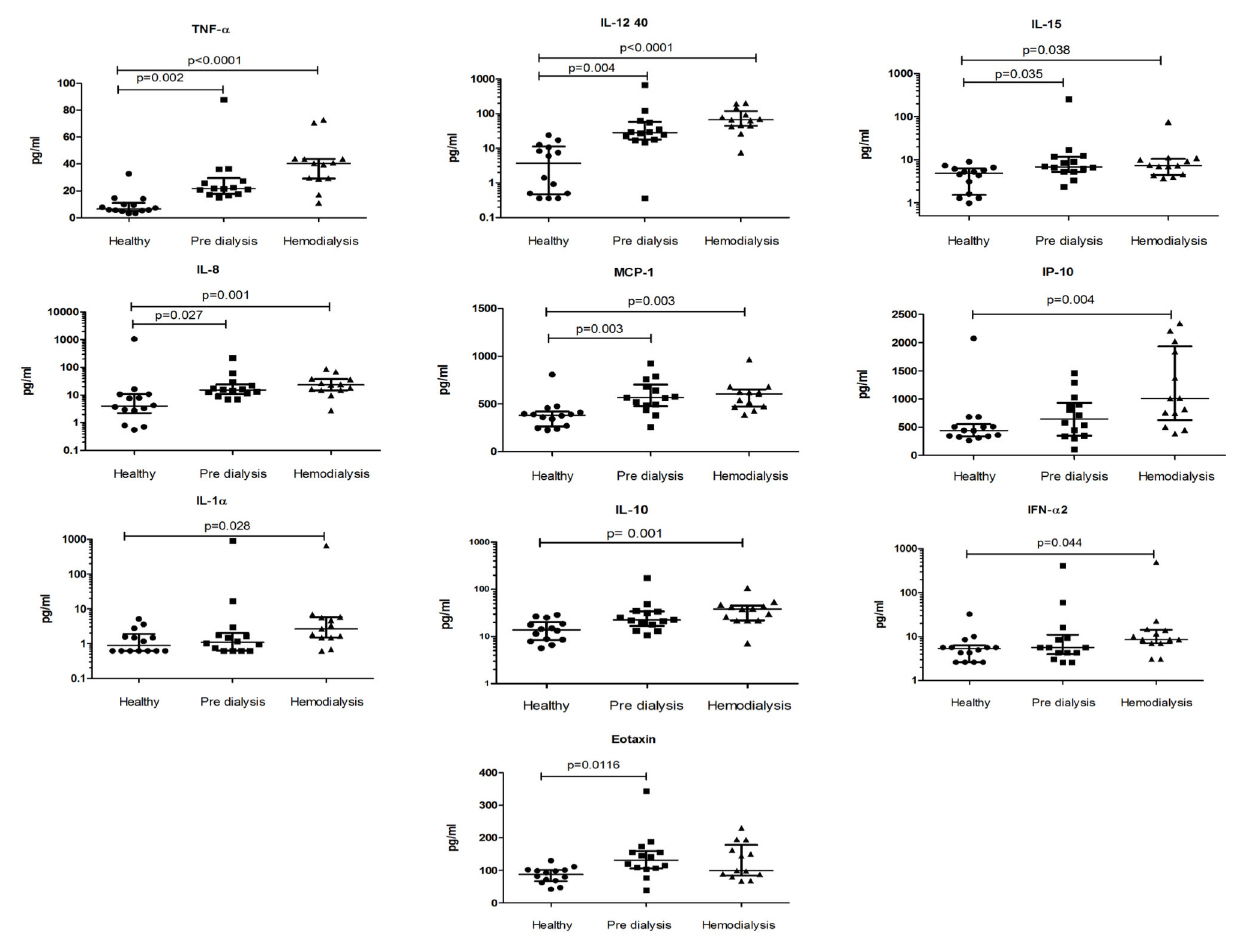
Figure 2. Scatter plots showing cytokines with significantly different plasma concentrations (pg/ml). The concentration of soluble immune modulators in the plasma of healthy controls, pre-dialysis patients and hemodialysis patients were analyzed and compared. Whiskers represent 25-75% interquartile range with the median shown by a line. Kruskal-Wallis test was used for comparison between the three groups. Significant differences between groups were analyzed using the post hoc Multiple Comparisons p values (2-tailed) test. p<0.05 was considered significant. doi: